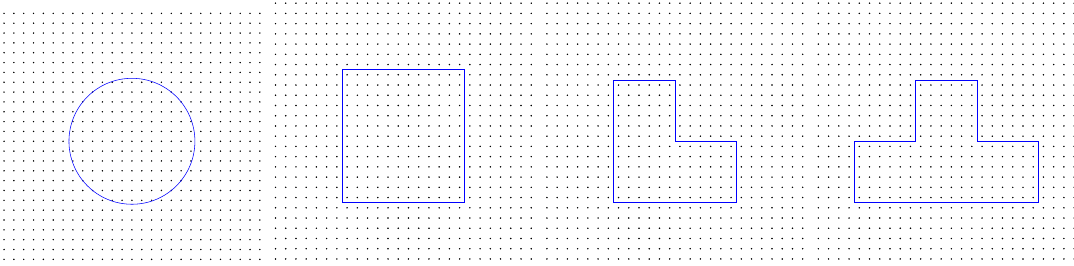
Figure 8 . Di(cid:11)erent entangling regions on a constant time slice of a (2 + 1)-dimensional Lifshitz (cid:12)eld theory. From left the (cid:12)rst panel shows a disk entangling region and the second one is a square region. The third and forth shapes are deformations of the square region. The area of the shape in the third panel is equal to that of the square but they have di(cid:11)erent number of corners (6 and 4 respectively). The shape in the forth panel with 8 corners, has the same volume as the square.